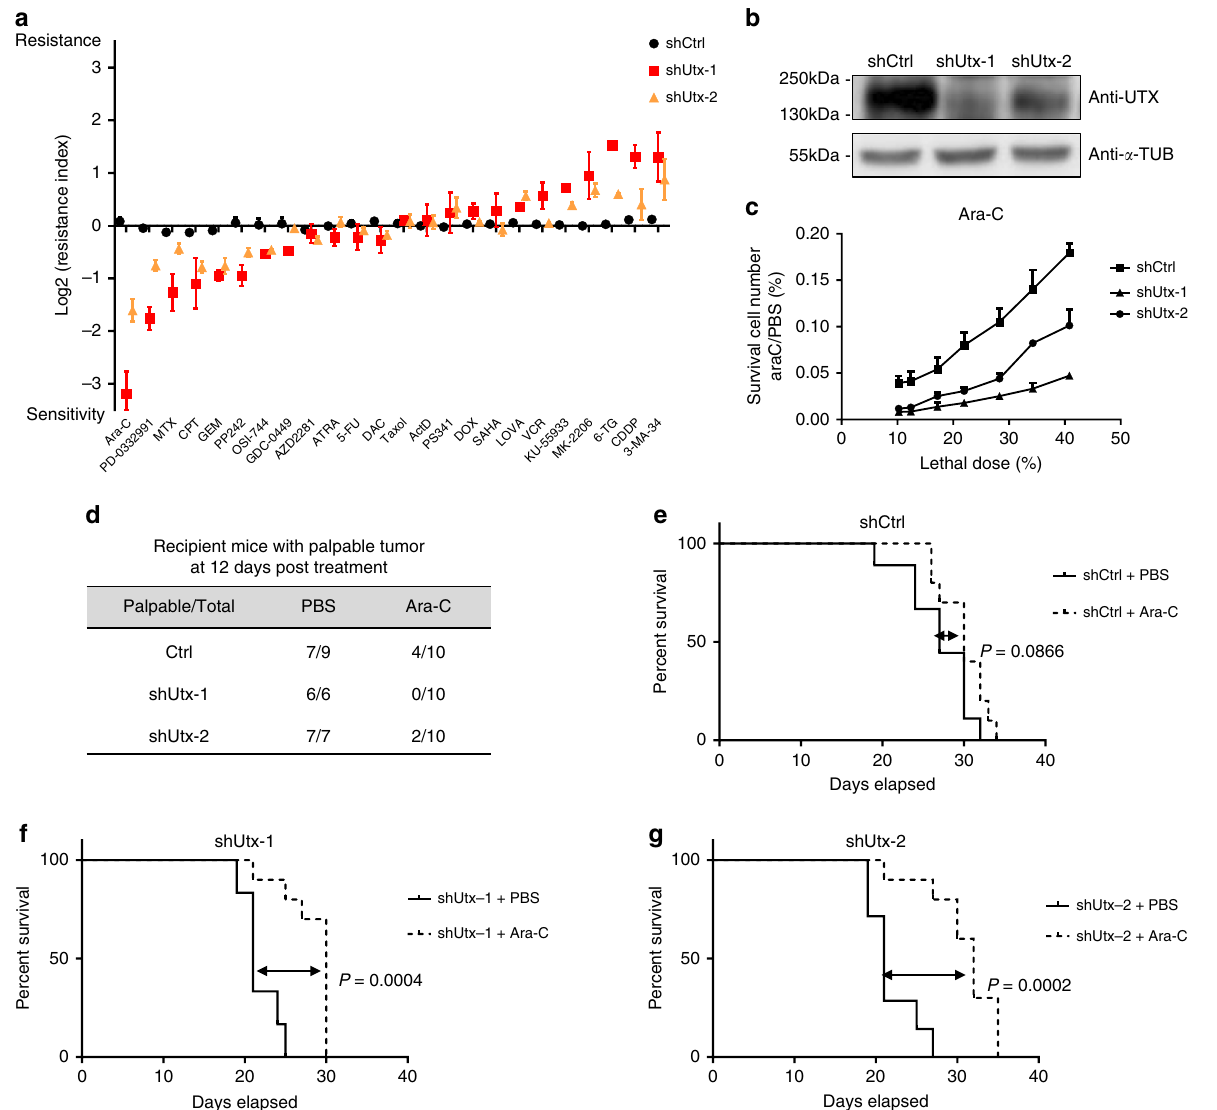
Fig. 5 UTX de fi ciency renders lymphoma cells hypersensitive to Cytarabine. a UTX-knockdown cells showed altered sensitivity towards certain drugs. Shown are mean ± SEM from three independent experiments. b A western blot showing knockdown ef fi ciency of UTX. c Upon knockdown of UTX, E μ -Myc; p19 Arf − / − lymphoma cells become more sensitive to Ara-C treatment. Shown are mean ± SD from three independent experiments. d Number of mice with palpable lymphomas 12 days post treatment. e – g Kaplan – Meier curves indicating the survival of mice injected with control or UTX-knockdown lymphoma cells, with or without Ara-C treatment. Statistical signi fi cance was determined using log-rank